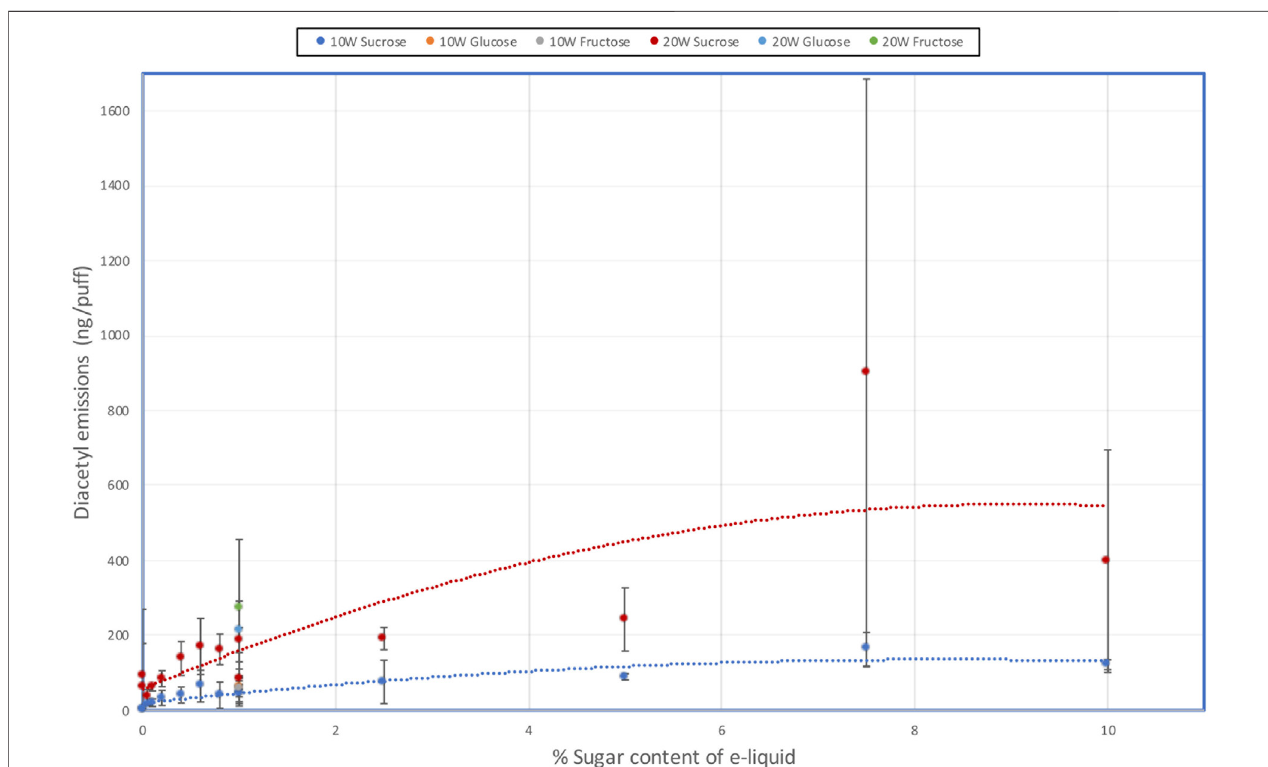
FIGURE 3 | Effect of e-liquid sugar levels on DA emissions from an e-cigarette at 10 W and 20 W power.